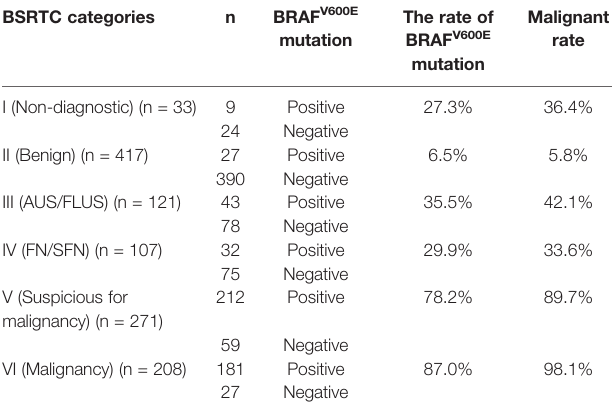
TABLE 3 | Correlations of BSRTC categories with BRAF V600E mutation and histopathological results.